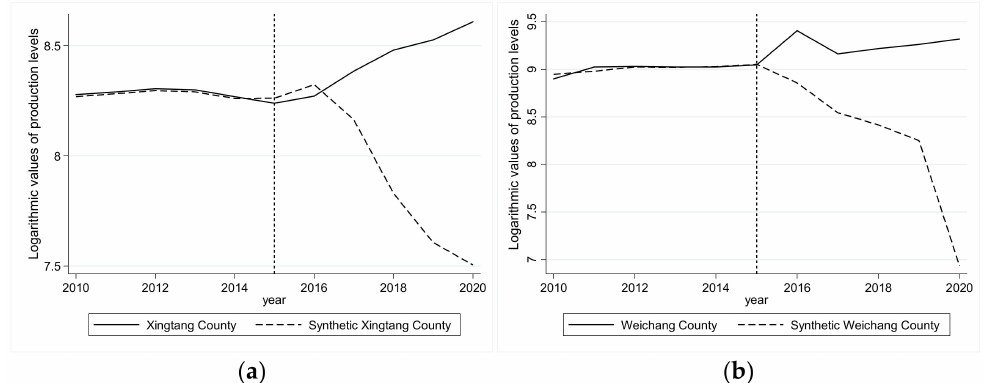
Figure 2. Effect of the CFFP on the production level of herbivorous livestock, ( a ) the trend of Xingtang County and synthetic Xingtang County; ( b ) the trend of Weichang County and synthetic Weichang